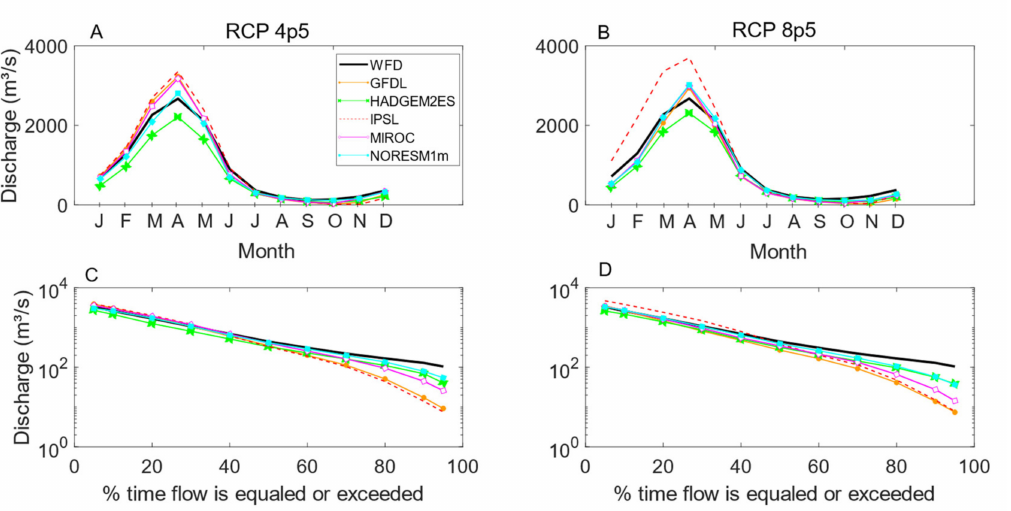
Figure 12. Seasonality of discharge ( A , B ) and exceedance probability of discharges ( C , D ) obtained using the input data for each GCM and both scenarios in the IRB. The black line presents the discharges obtained using the WFD input